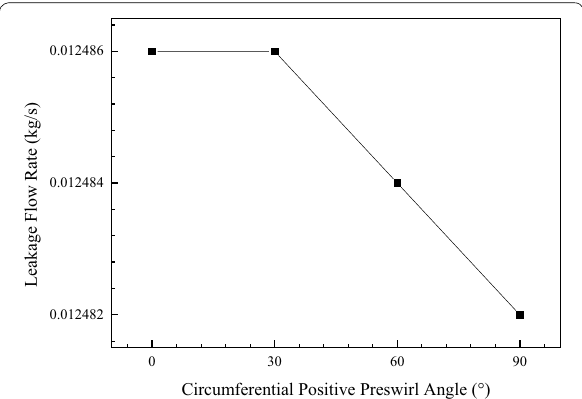
Figure 11 Leakage flow rate versus circumferential positive pre-swirl